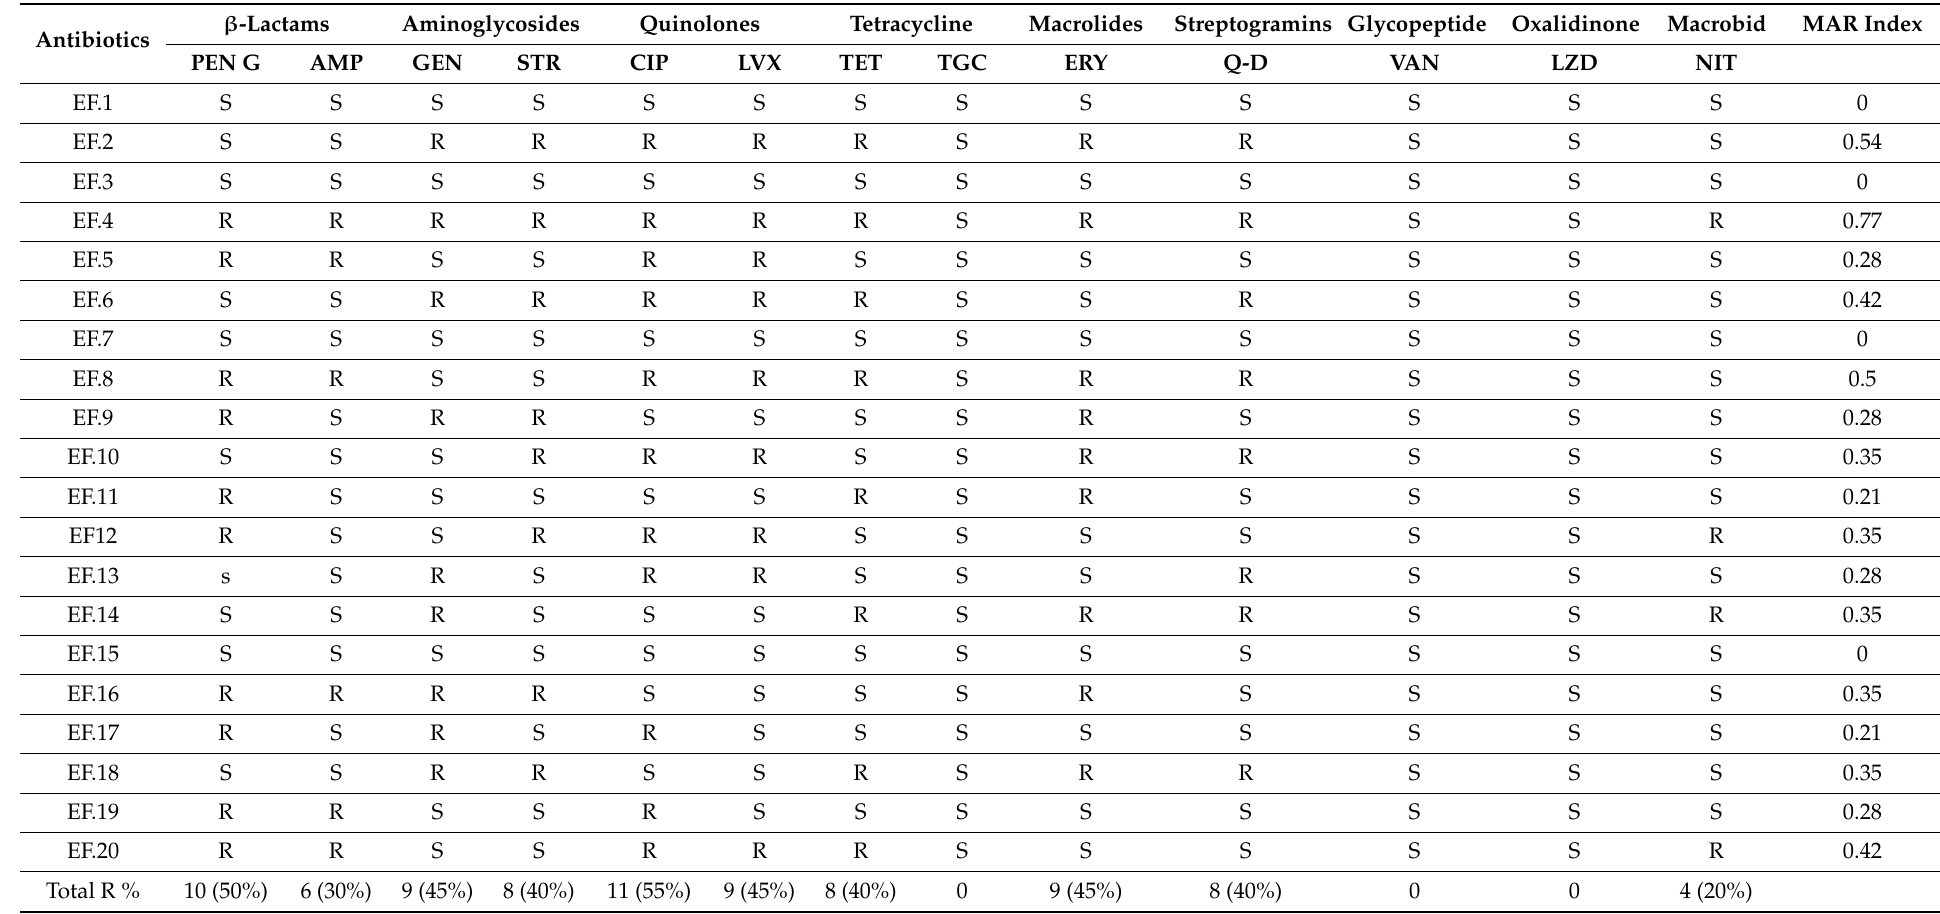
Table 1. Antibiotic sensitivity of E. faecalis root canal